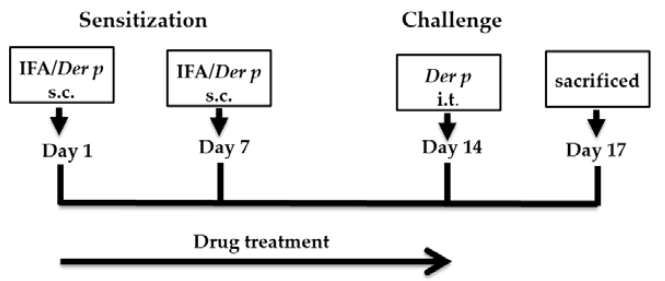
Figure 10. Experimental protocol of allergic sensitization and challenge.